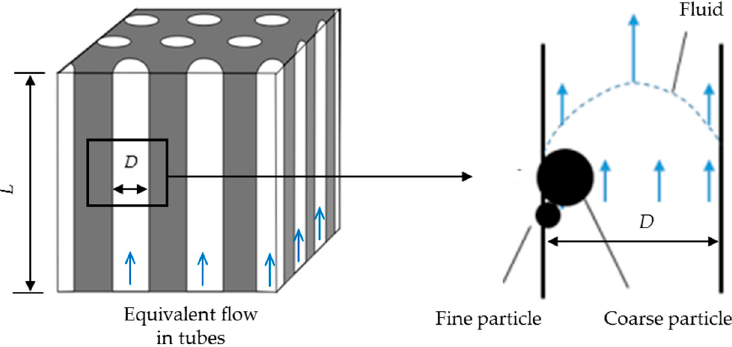
Figure 3. Effect of GSD in suffusion process. Figure 3. E ff ect of GSD in su ff usion